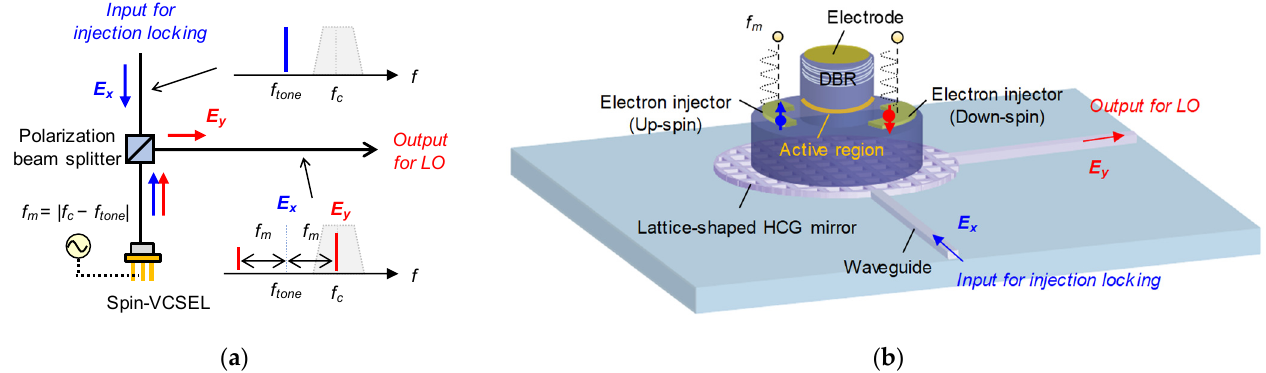
Figure 2. ( a ) Schematic of frequency-shifted LO based on injection-locked spin-VCSEL; ( b ) Example device structure of frequency-shifted LO with integrated configuration.